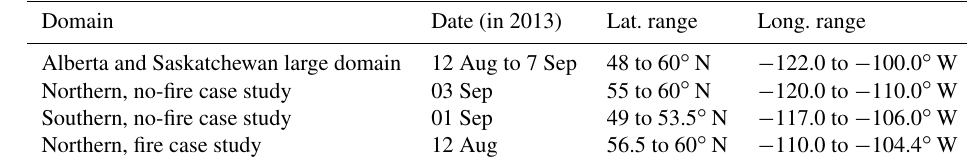
Table 1. Latitude and longitude ranges that the model was evaluated over with the CrIS satellite measurements.